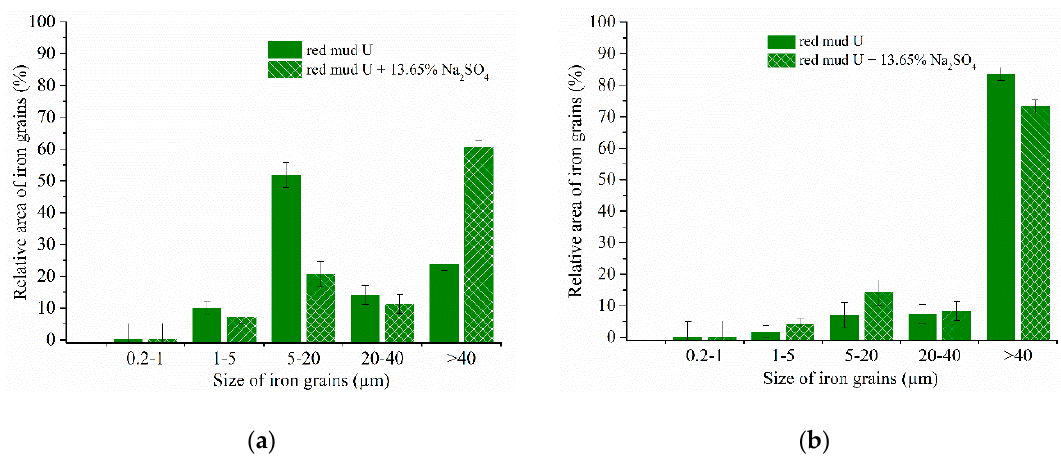
Figure 8. Effect of 13.65% Na 2 SO 4 addition to the red mud sample U on the relative area of iron grains of different fractions after 180 min of roasting at 1350 °C ( a ) and 1400 °C ( b ).